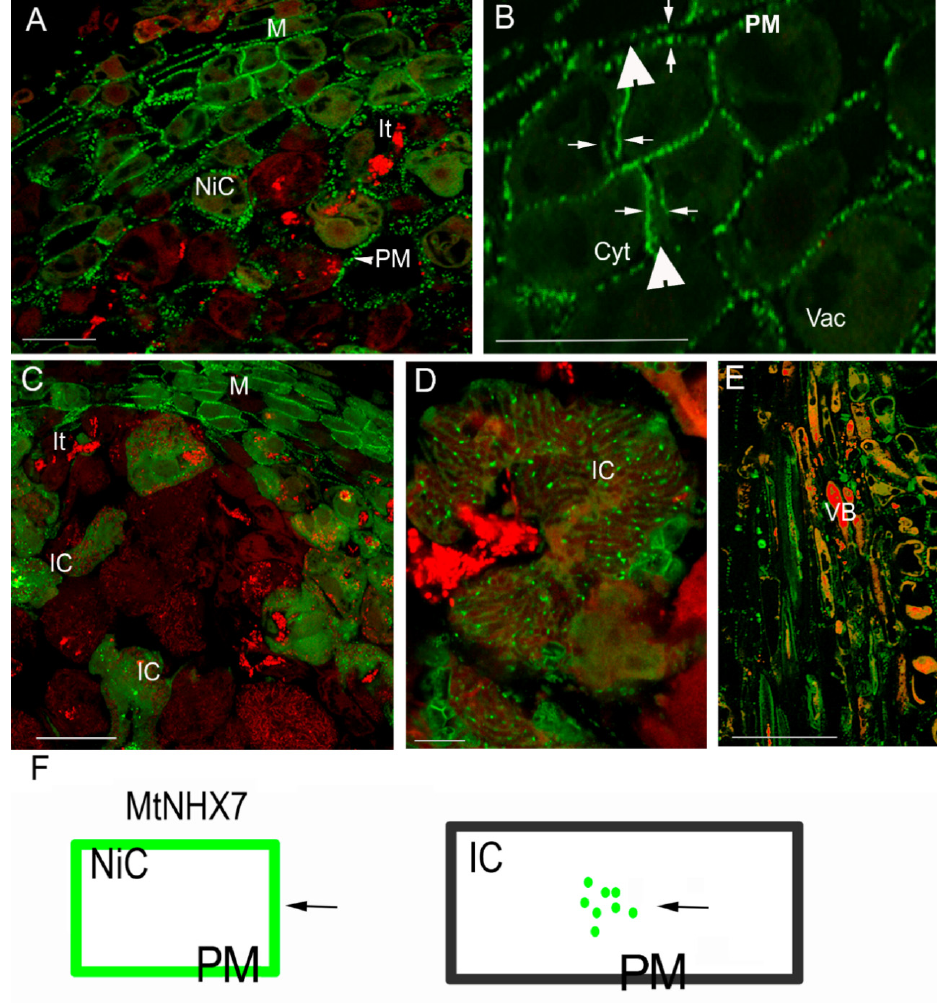
Figure 1. Confocal microscopy immunolocalization of the MtNHX7 protein in the transgenic nodules carrying the ProMtNHX7:MtMTNHX7:GFP construct ( A – E ), and the scheme of protein distribution in infected and non-infected cells as per immunosignal (in green color) to explain the localization pattern and its changes ( F ). Color code: red fluorescence—propidium iodide counterstained bacteria and nuclei, green fluorescence—protein labeling. MtNHX7 distribution was visualized by GFP signal in the sections carrying the ProMtNHX7:MtNHX7:GFP construct. Green fluorescence in the nodule meristem and distal infection zone (close to the meristem) was detected in the plasma membrane (arrowhead). ( B ) High magnification of fraction of ( A ). Note the immunosignal is distributed in double rows decorating the plasma membranes of neighboring cells (arrows), separated by the cell wall (arrowhead). ( C ) Distal infection zone and fully infected cells situated below the infection zone, MtNHX7 is detected in the plasma membrane in meristematic cells and in cells containing freshly released bacteria. ( D ) Infected cells with MtNHX7 signal present in a dot-like pattern in the cytoplasm. ( E ) Localization of MtNHX7 in the vascular bundles; note the strong membrane signal. ( F ) Scheme of protein distribution in infected and non-infected cells. The arrow is pointing to the green immunosignal. Green rectangular box is representing the plasma membrane (PM) of non-infected cell, that retained the immunosignal, black rectangle is representing the PM of infected cell, with no green signal present, the green labelled protein is located in the cytoplasm in do-like pattern. IC: infected cell, NiC: non-infected cell, M: meristem, It: infection thread, Vac: vacuole, VB: vascular bundle, T: tonoplast. Arrowhead: signal over the plasma membrane (PM). Bars: ( A , B , E ): 50 µ m; ( C ): 25 µ m; ( D ): 10 µ